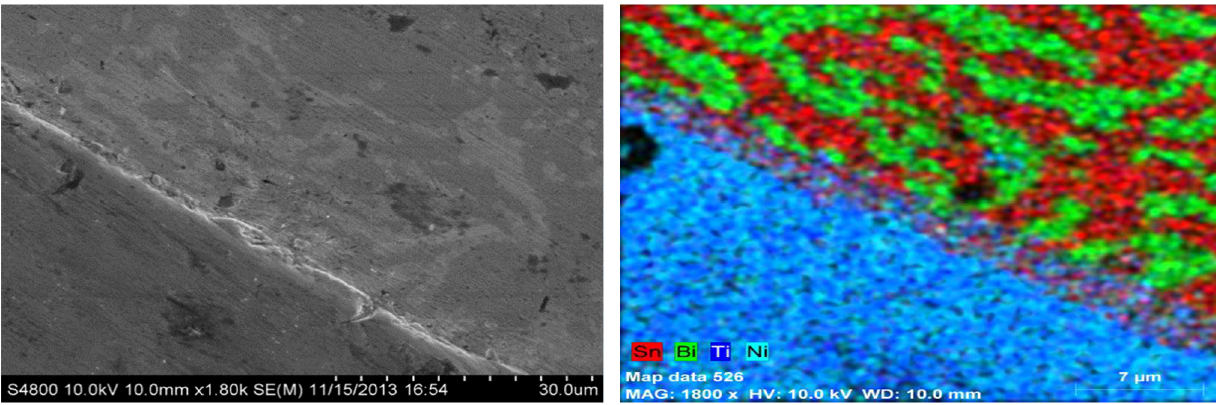
Figure 4. Elemental maps of the interface between Sn-Bi and NiTi. Reprinted/adapted with permission from Ref. [20]. 2013, Shobhit Misra.